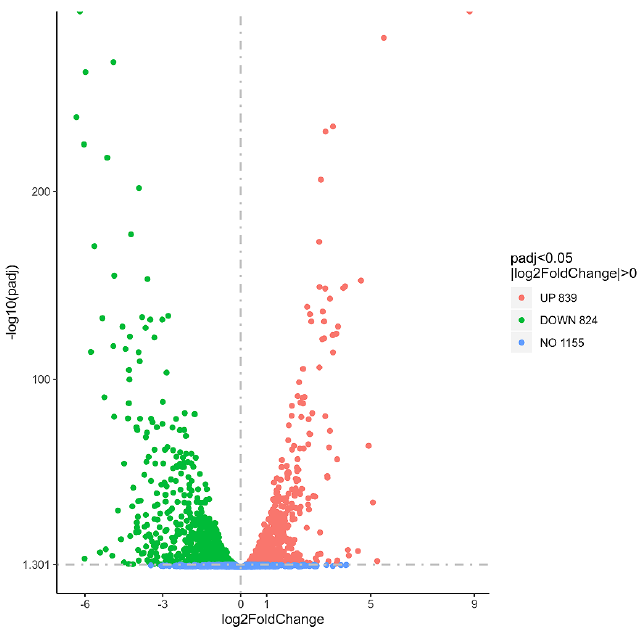
Figure 7. Scatter plot of differentially expressed genes (DEGs) of control vs. treatment group.